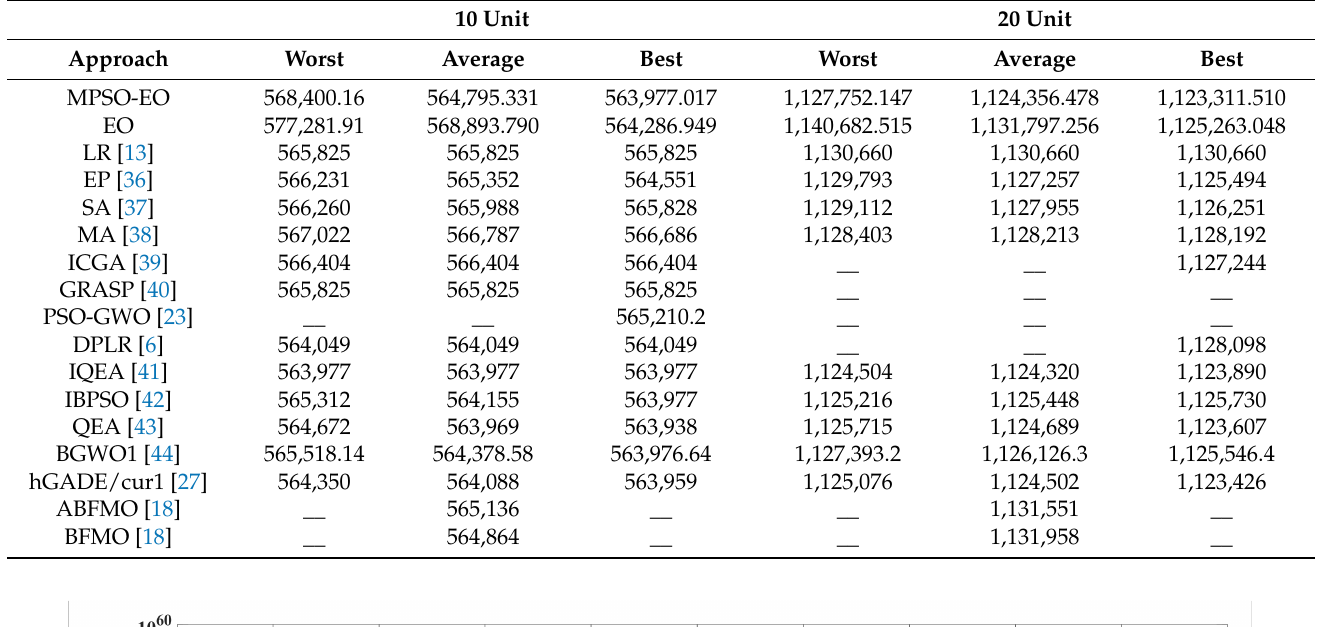
Table 9. Comparison of MPSO-EO with other algorithms (test system 1).